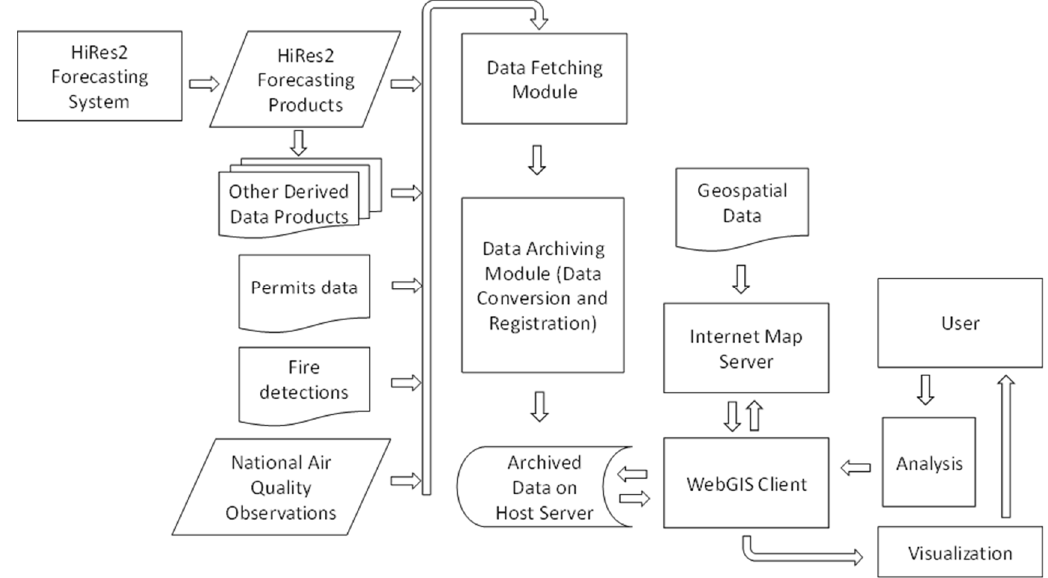
Figure 1. Conceptual architecture of the Southern Integrated Prescribed Fire Information System (SIPFIS) system.